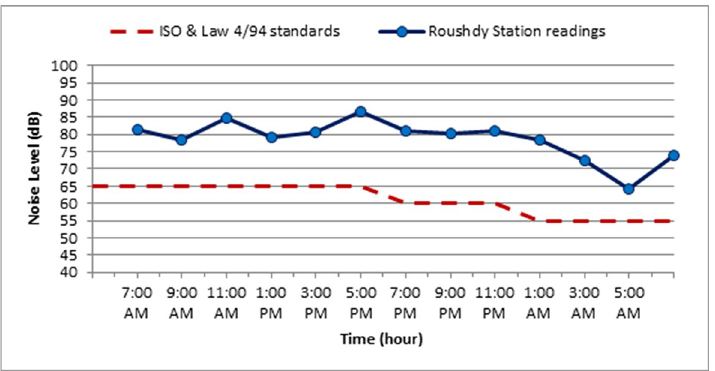
Fig 8. The variation of noise levels at ROS along the different intervals of the day compared to the standard permissible limit for noise levels according to ISO standards and Egyptian Environmental law 4/94.